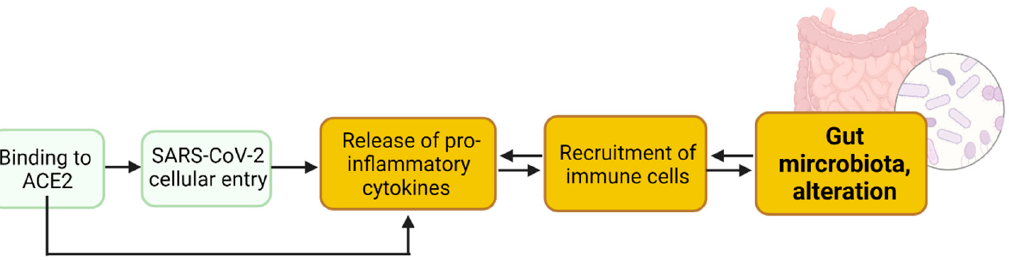
Figure 1. Spike proteins of SARS-CoV-2 virus binding to ACE2 receptor expressed in enterocytes mediates viral entry inducing intestinal inflammation (release of pro-inflammatory mediators and re- cruitment of inflammatory cells) leading to alteration of gut microbiota. Created with